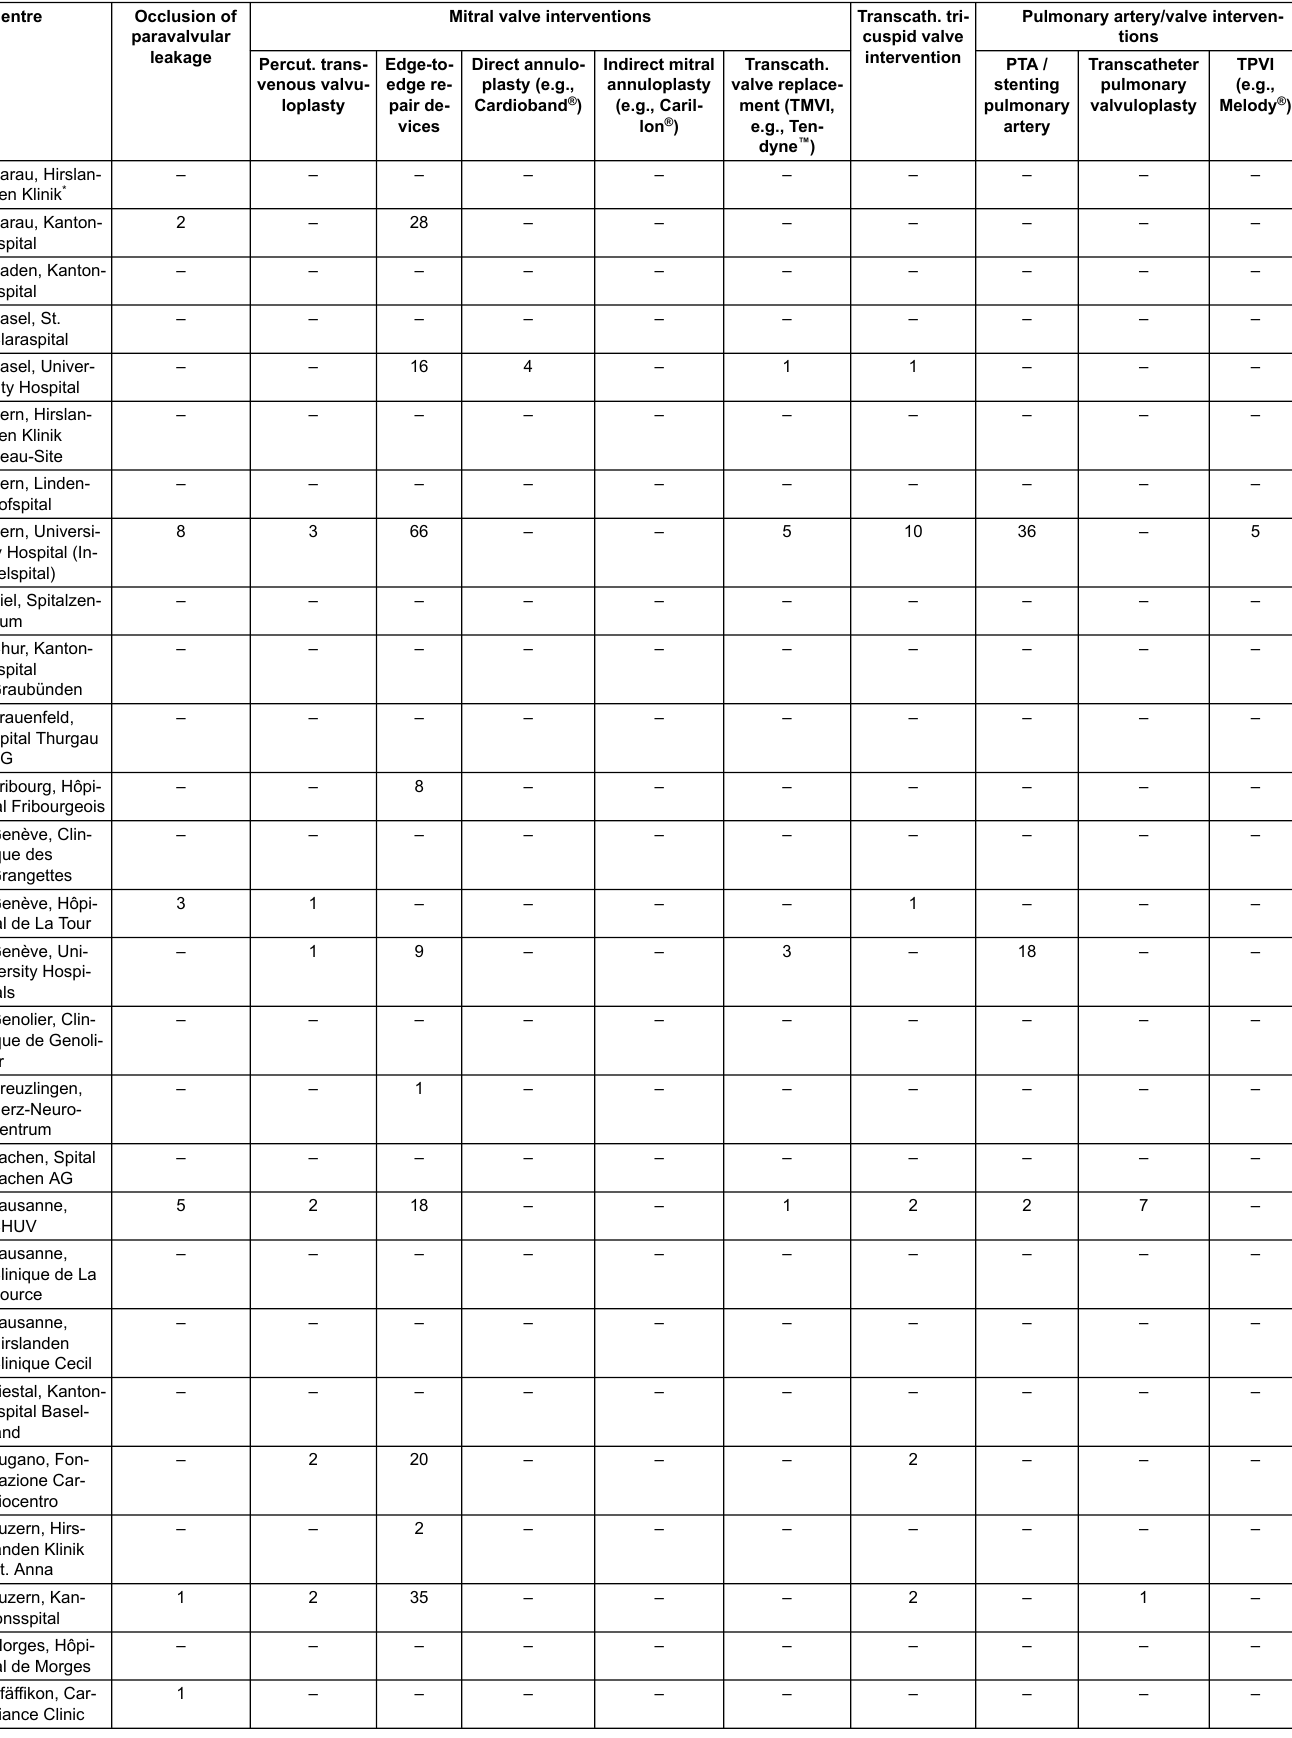
Table 7: Interventional valve interventions other than TAVI in Switzerland 2019.